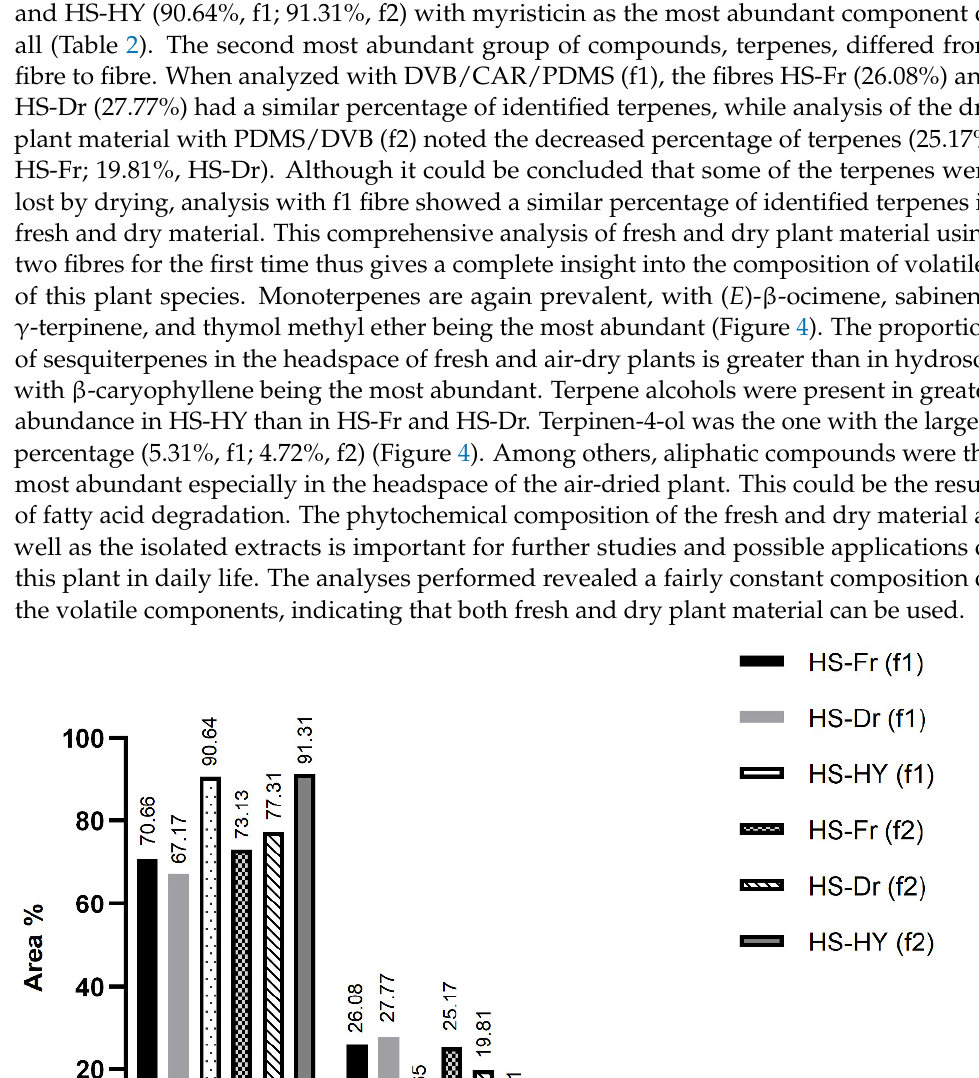
Figure 3. The volatile organic compounds of P. ramosissima extracted by headspace solid-phase microextraction, analyzed by gas chromatography-mass spectrometry and sorted by structural groups. Extraction by divinylbenzene/carboxene/polydimethylsiloxane fibre (f1): HS-Fr (f1)—fresh P. ramosissima ; HS-Dr (f1)—air-dried P. ramosissima ; HS-HY (f1)—hydrosol of air-dried P. ramosissima . Extraction by polydimethylsiloxane/divinylbenzene fibre (f2): HS-Fr (f2)—fresh P. ramosissima ; HS-Dr (f2)—air-dried P. ramosissima ; HS-HY (f2)—hydrosol of air-dried P. ramosissima .